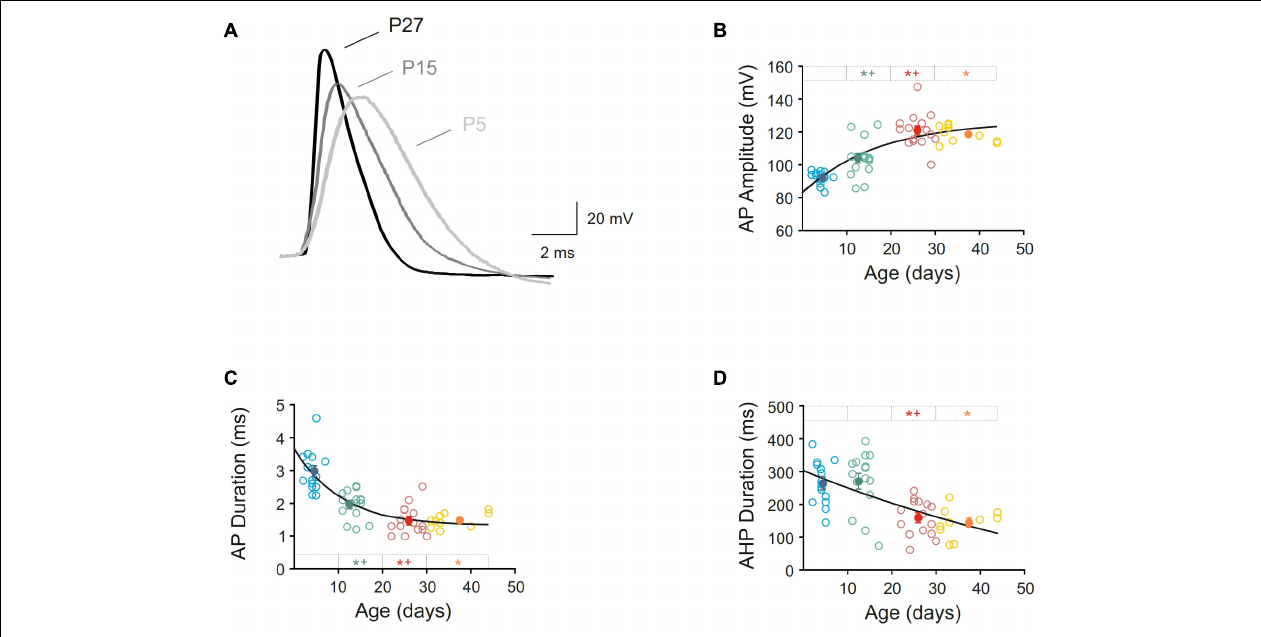
FIGURE 4 | Postnatal development of action potential characteristics of motor cortex pyramidal neurons. (A) Membrane voltage responses to suprathreshold stimuli in three representative neurons from newborn, infantile and young adult age groups. Action potentials were synchronized at the beginning of the rising phase to show the differences in amplitude and duration. (B–D) Scatter plots showing the amplitude of action potential (B) , duration of action potential (C), and duration of afterhyperpolarization phase or AHP (D) as a function of postnatal age. Open symbols represent the raw data, while filled symbols are the means of the four different age groups and their standard errors. Each group is represented by a color (blue = newborn, n = 15; green = infantile, n = 15; red = young adult, n = 15; yellow = adult, n = 10). An asterisk indicates a significant difference from the newborn group; a cross indicates a difference between adjacent groups. The significance level was established as p ≤